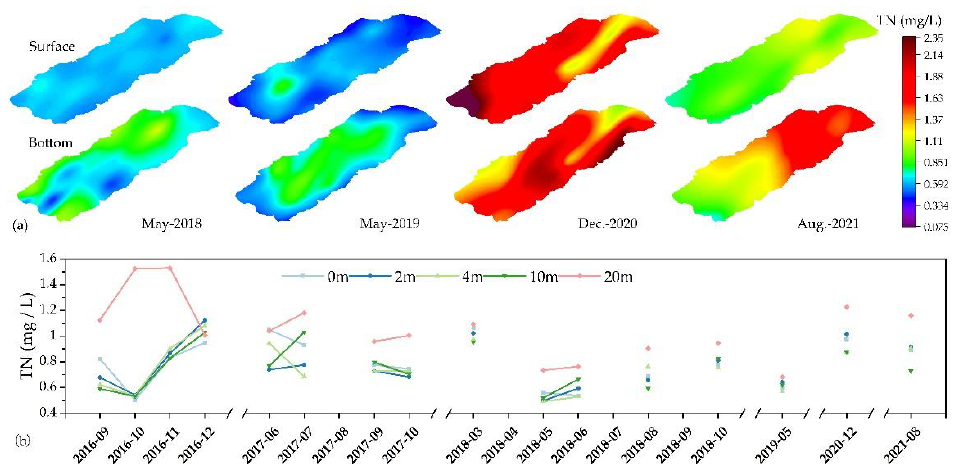
Figure 9. Change in TN content in Lake Yangzong from 2017 to 2021. ( a ) indicates the distribution of TN content in the whole lake at the surface and bottom. ( b ) represents the mean value of TN content at 5 different depths.